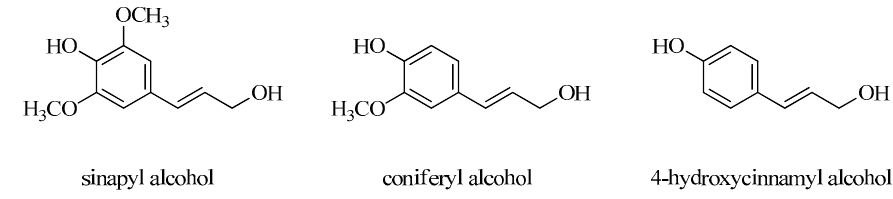
Figure 3. Molecular structures of lignin units.